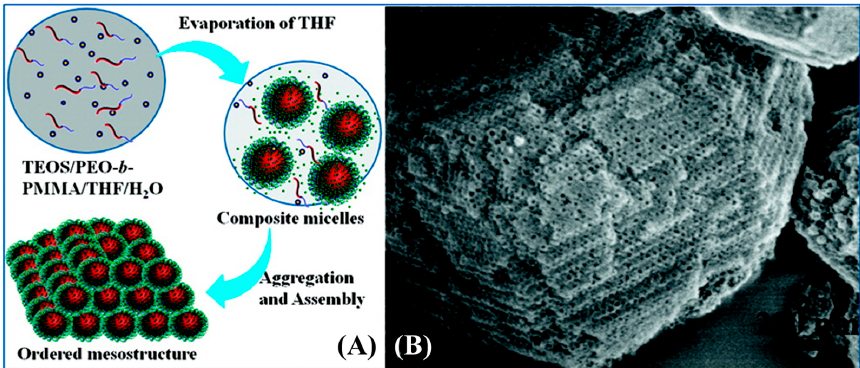
Figure 20. ( A ) Formation mechanism of ordered mesoporous silica through the solvent evaporation -induced aggregating assembly (EIAA) process by using diblock copolymer PEO- b -PMMA as a template, tetraethylorthosilicate (TEOS) as the silica source, and acidic tetrahydrofuran (THF)/H 2 O